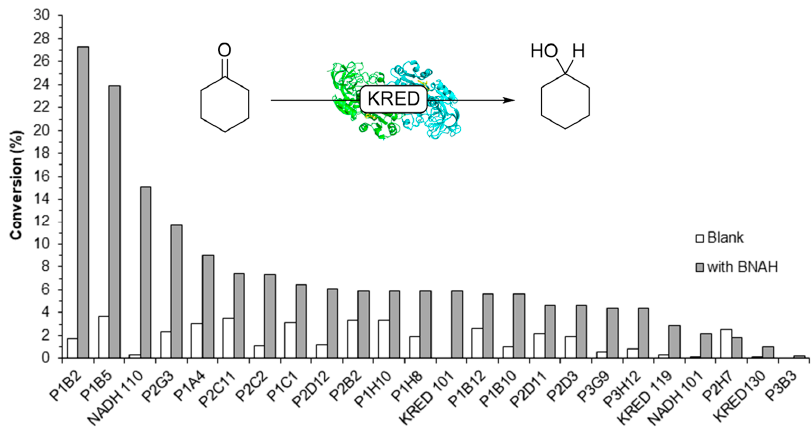
Figure 4. Screening of the ketoreductases (KREDs) Codexis kit. X-axis: KREDs. Y-axis: conversion to cyclohexanol after 24 h, measured by GC analysis, with BNAH (grey) and without BNAH (white). Reactions conditions: 50 mM KPi pH 7.0, [cyclohexanone] = 10 mM, [KRED] = 10 mg/mL, [BNAH] = 10 mM (where applicable).